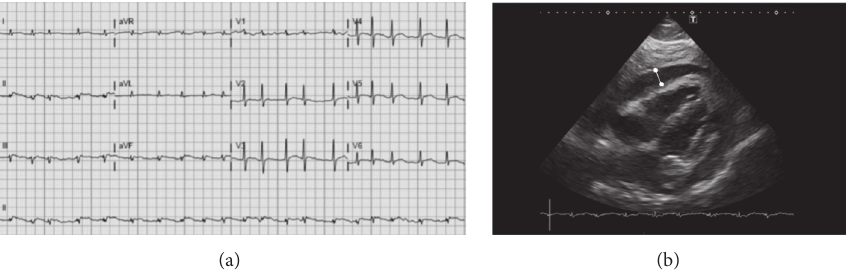
Figure 2: ECG and echocardiography on day 4. (a) Twelve-lead ECG during the fourth day of admission shows atrial fibrillation and microvoltages, indicative of increased pericardial effusion. (b) Ultrasound studies confirmed the presence of large ( > 20mm) pericardial effusion, here shown on the subcostal view and indicated with the white marker.